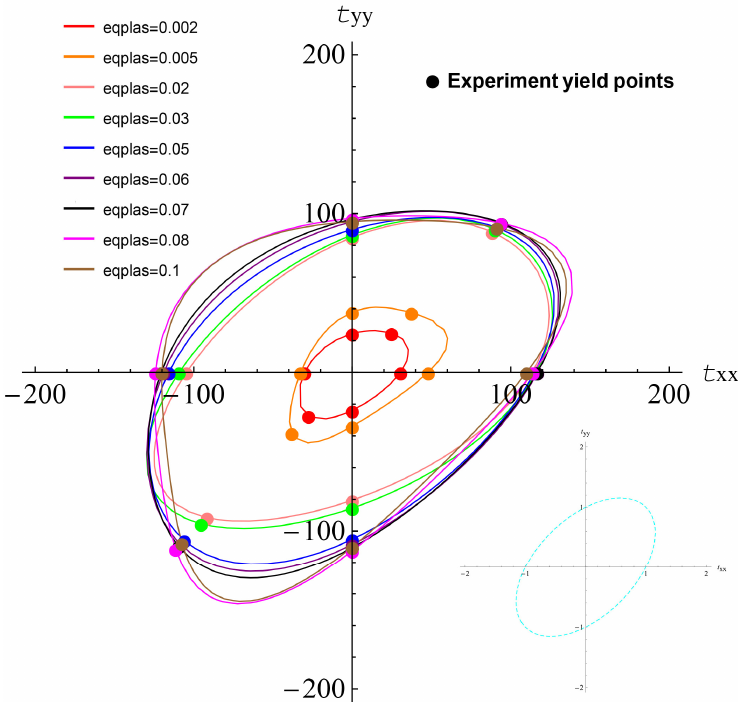
Figure 5. Schematic diagram of the yield surface and experimental yield point of ZK60 magnesium alloy samples (unit: MPa; the isotropic yield surface (aqua dashed line) is the 45 ◦ inclined ellipse in the two-dimensional stress